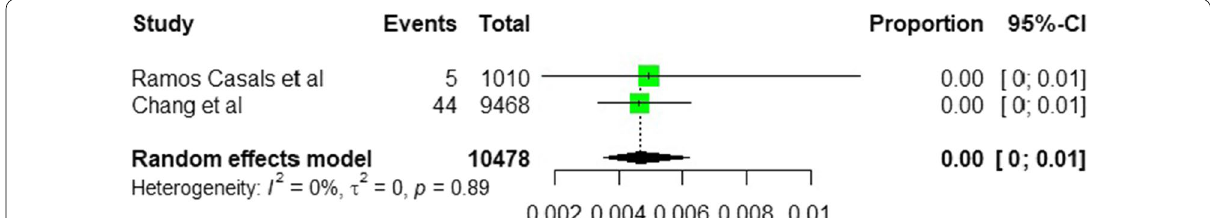
Fig. 4 Meta‑analysis of the Acute pancreatitis prevalence in Sjögren syndrome (pSS)